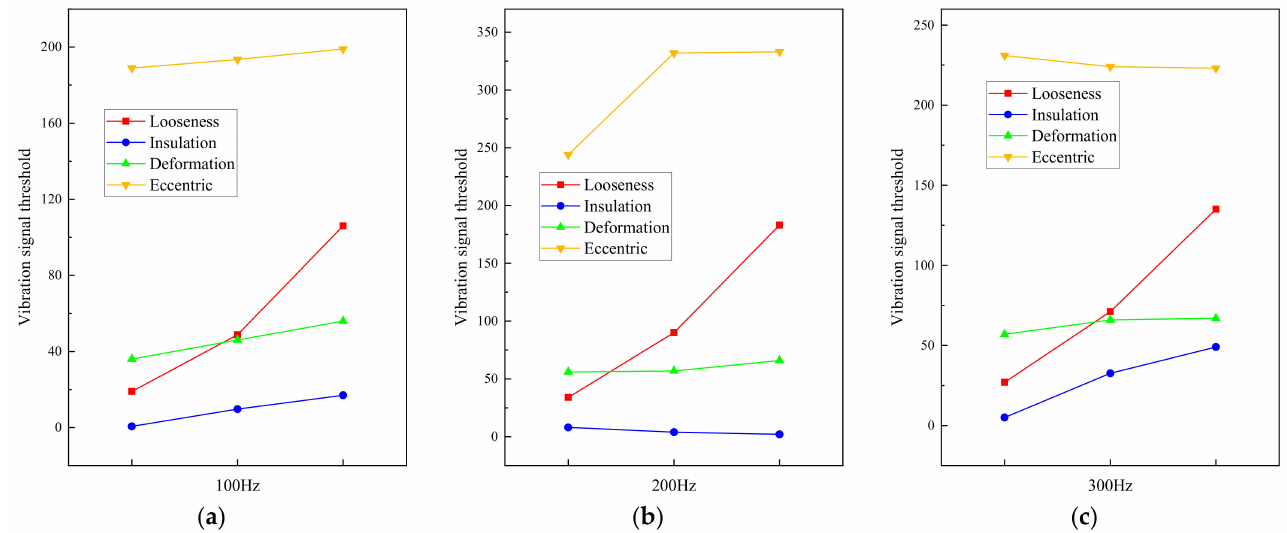
Figure 18. Broken line diagram of the vibration increment threshold K i at point 1 on the winding surface. ( a ) Line chart of the vibration increment threshold at 100 Hz; ( b ) line chart of the vibration increment threshold at 200 Hz; ( c ) line chart of the vibration increment threshold at 300